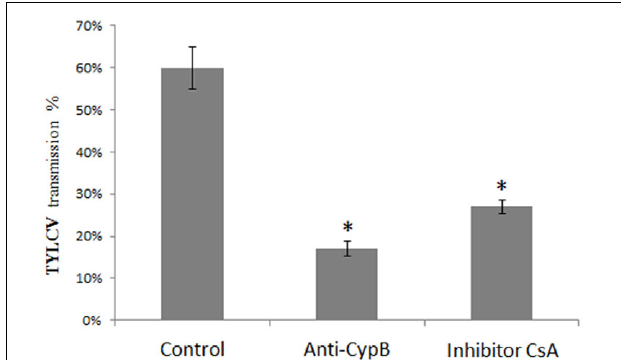
FIGURE 7 | Decrease in TYLCV transmission rates after feeding of adult whiteflies on artificial medium containing 25% sucrose (control), artificial medium containing anti-CypB antibodies (anti-CypB) and the cyclophilin inhibitor CsA, for 24 h, followed by feeding on the TYT plants for 48 h, before performing transmission experiments of one insect/plant as detailed in the text. Data shown are the means and standard errors from three independent experiments. Asterisks indicate statistically significant differences with P < 0.05 between transmission experiments compared to the control.